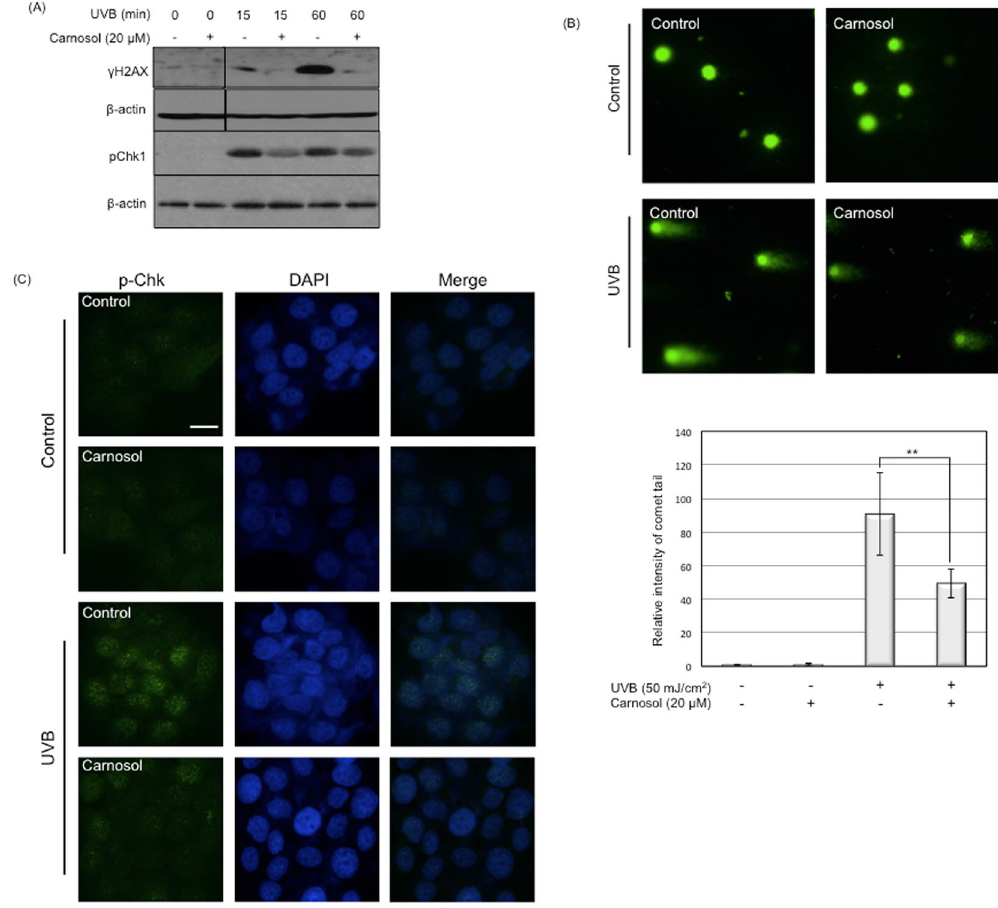
Figure 3. Carnosol protects UVB-induced DNA damage. HaCaT cells were exposed to 50 mJ/cm 2 UVB radiation in the presence or absence of carnosol (20 μ M). ( A ) Cells were lysed at indicated time point and protein levels of phosphorylated H2AX ( γ H2AX) and Chk1 (p-chk1) were determined by western blot. The data represents three sets of independent experiments. ( B ) Comet assay for HaCaT exposed to UVB radiation. After cell treatment, cells were trypsinized and collected for comet assay. The tail intensity was semi-quantitatively analyzed using Image J. * p < 0.05, ** p < 0.01. ( C ) Cells were immunostained with p-Chk1 upon UVB radiation with or without carnosol (20 μ M) treatment. p-Chk1 was stained with green fluorescent dye, while nucleus was stained with DAPI. Scale indicates 20 μ